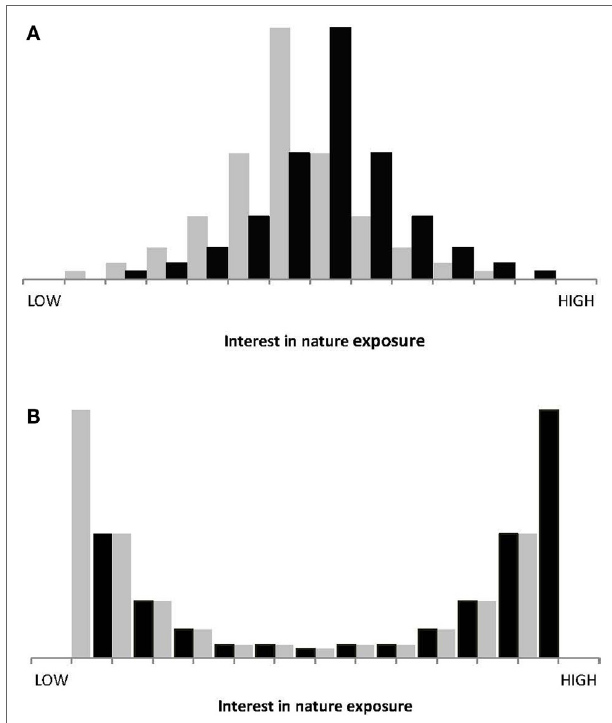
FigUre 1 | conceptual distributions of individual in nature exposure . Gray: prior to public health intervention. Black: after intervention. (a) Current unimodal view. (B) Alternative bimodal view. All bar heights are conceptual